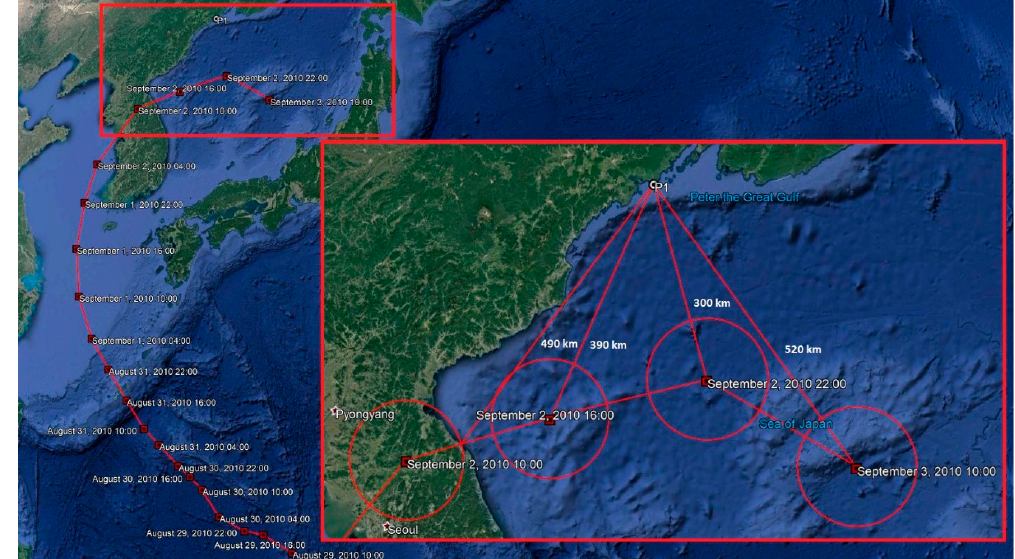
Figure 4. Typhoon KOMPASU trajectory. Point P1—“Vityaz” Bay, the points of the typhoon passage are indicated by the date and time (local time), red circles indicate areas with winds exceeding 18 m / s, the area radius is 90 km. Distances to “Vityaz” Bay are noted for three points of the typhoon distribution.